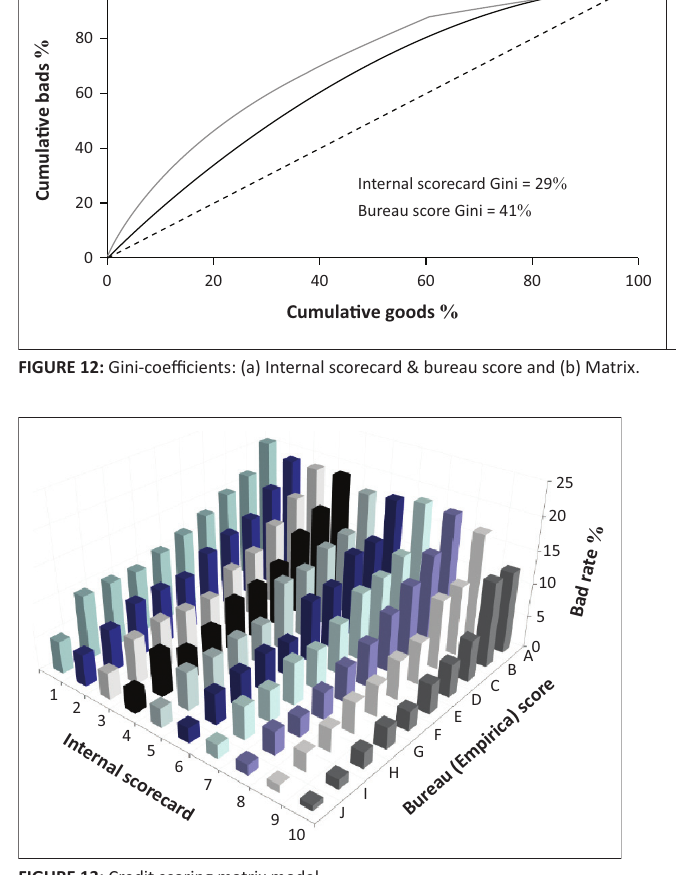
FIGURE 13: Credit scoring matrix model. TABLE 10: One-dimensional score (internal application score). Internal application